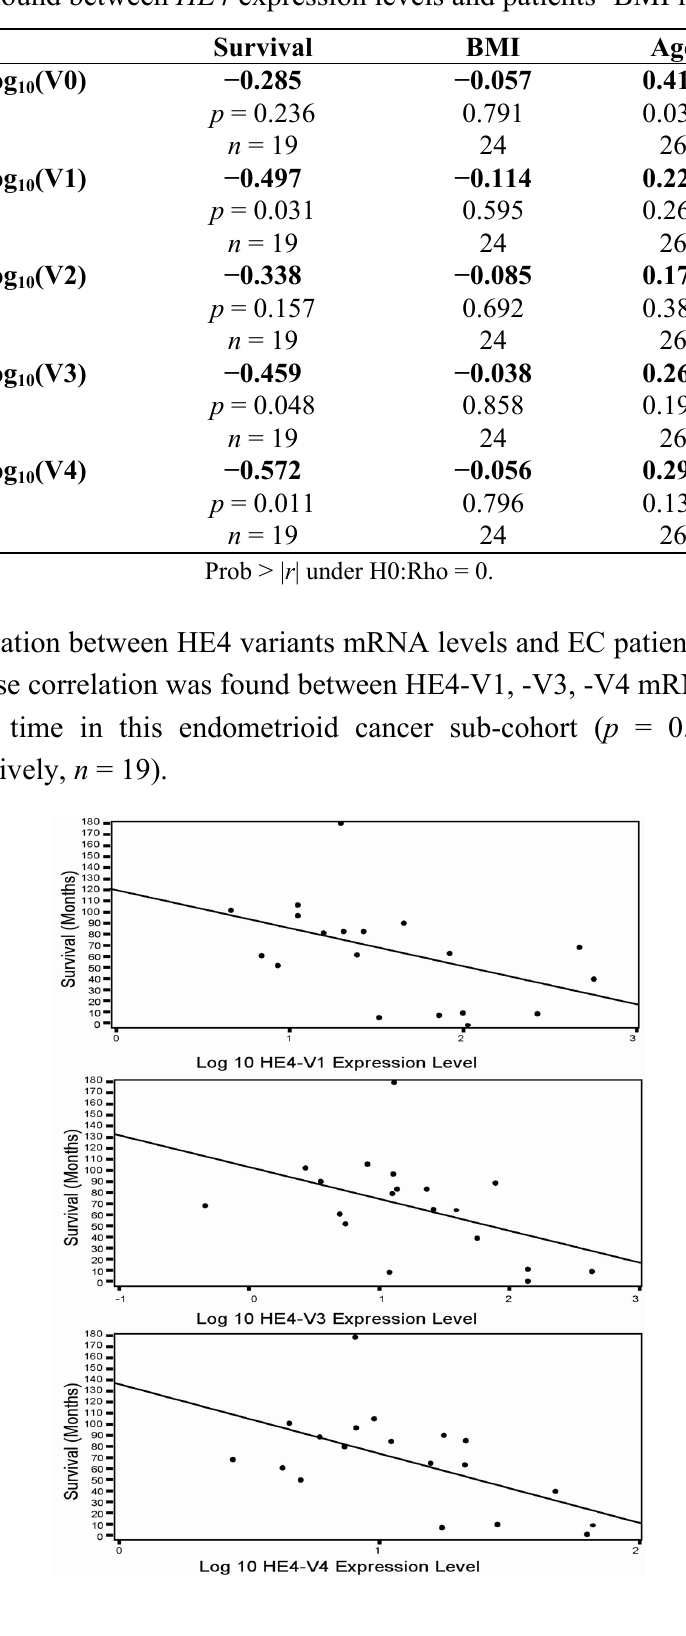
Table 5. Correlation of HE4 variants expression levels with endometriod EC patients’ clinical data. A significant inverse correlation between three of the variants ( HE4 -V1, -V3, -V4) and patients’ survival were found in endometrioid EC group. There was also a positive correlation found between variants HE4 -V0 and patients’ age. No significant correlation was found between HE4 expression levels and patients’ BMI in this group.